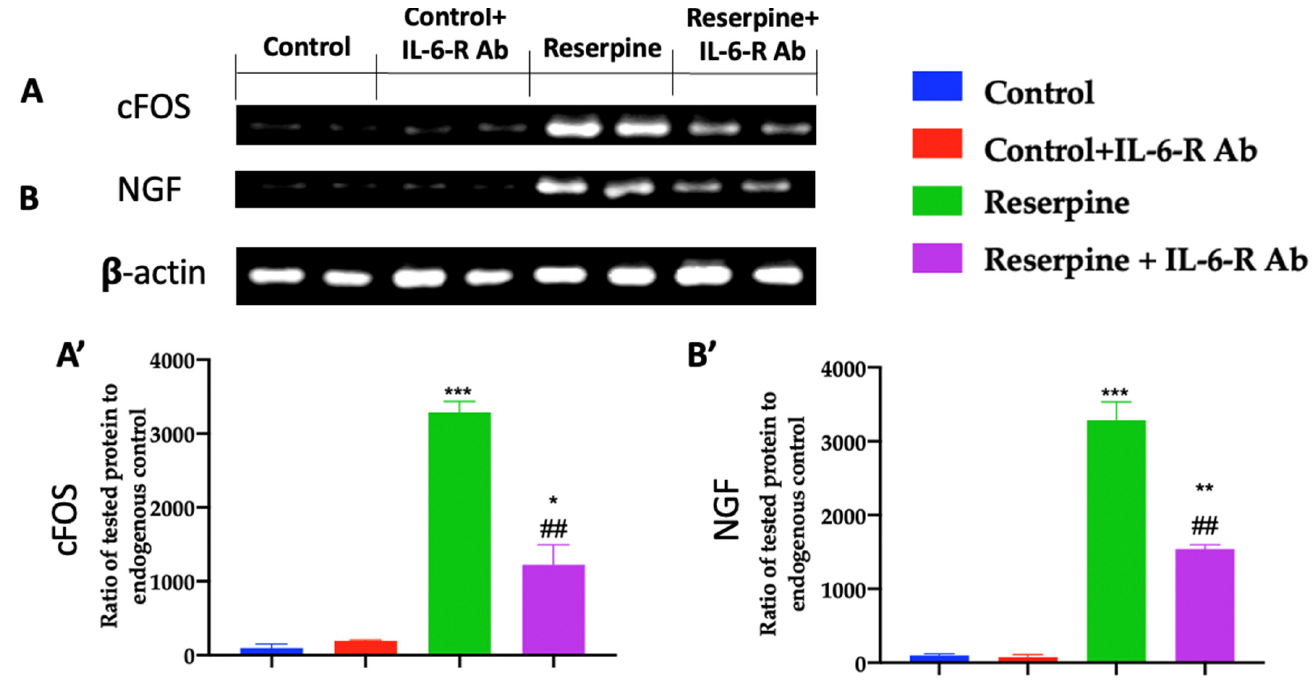
Figure 3. Effects of IL-6-R Ab on pain-related mediators: Western-blot analysis of: ( A , A’ ) cFOS and ( B , B’ ) NGF expressions.